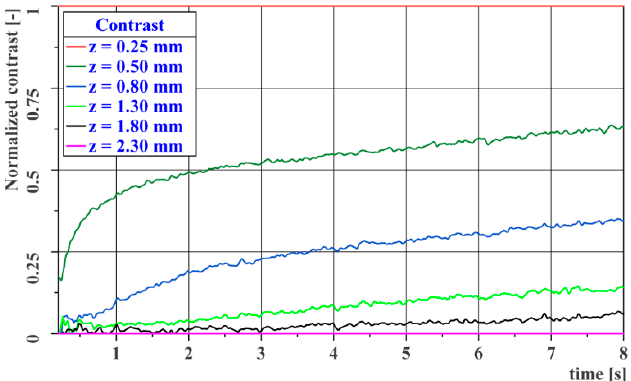
Figure 14. DAC image contrast curves for the reference gauge.